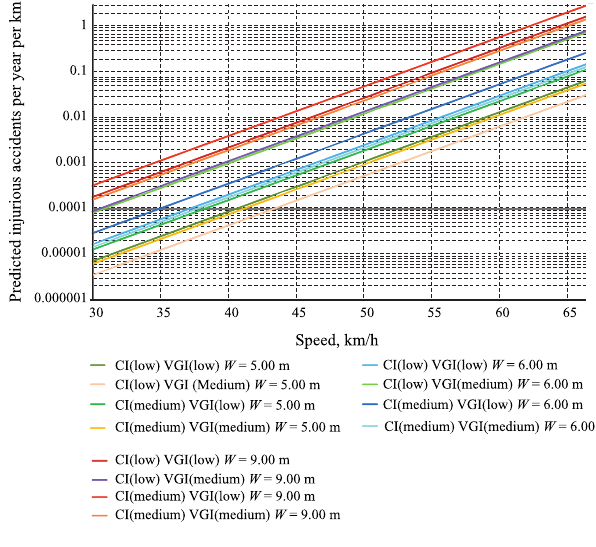
Roads on the flat/rolling area